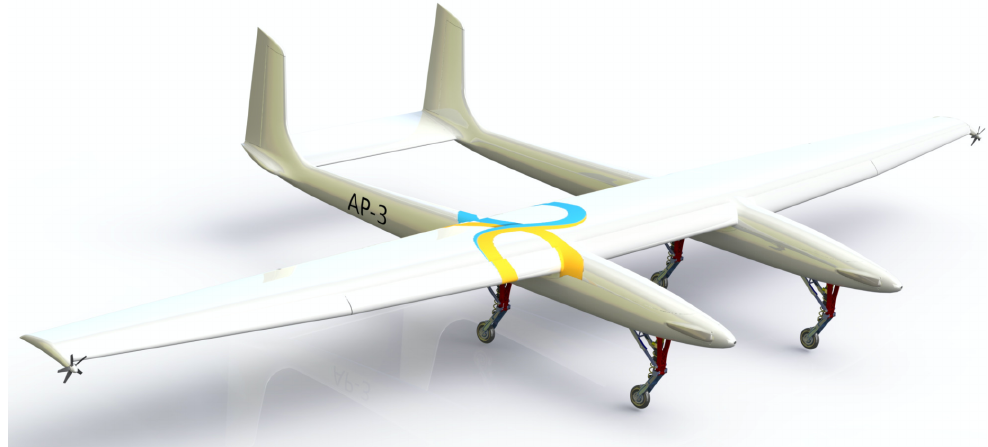
Figure 1. The Ampyx Power AP3 featuring a quadruple landing gear